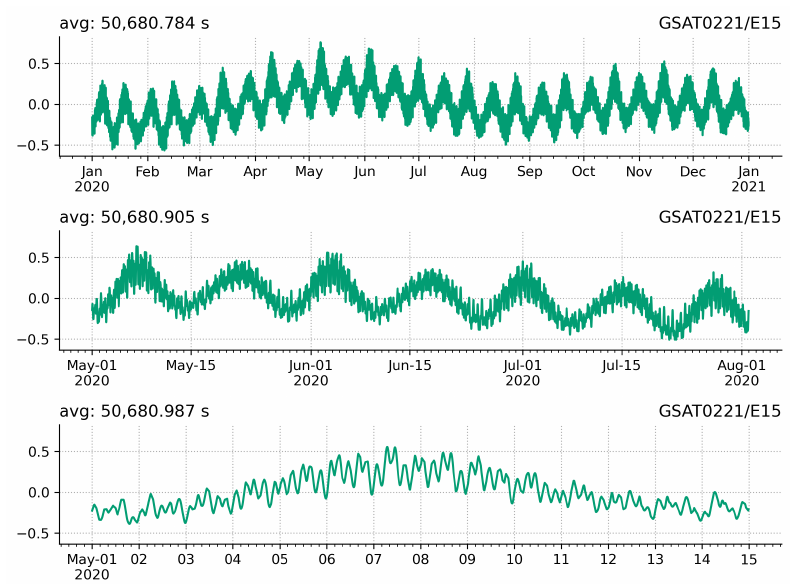
Figure 6. Periodic variations in the orbit repeat period over different periods of time. The top plot displays the variations for year 2020. Time marks for the 7th, 14th, 21st and 28th day of each month in 2020 are also given for guidance. The middle plot displays the variations over a three month period from May to the end of July 2020. Daily tick marks are also plotted. The bottom plot displays the variations during May 2020. Marks for every four hours within a day are also plotted. [Unit: